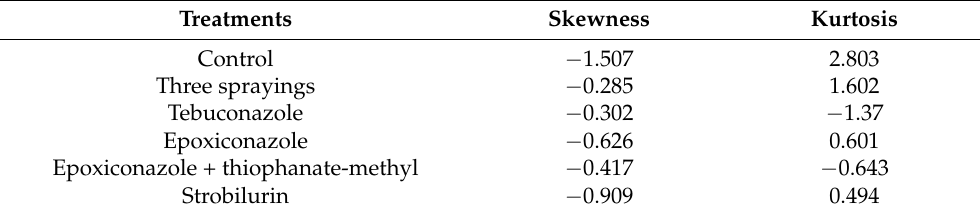
Table 5. Asymmetry of degree of leaf infestation in the study years, by fungicidal protection method.